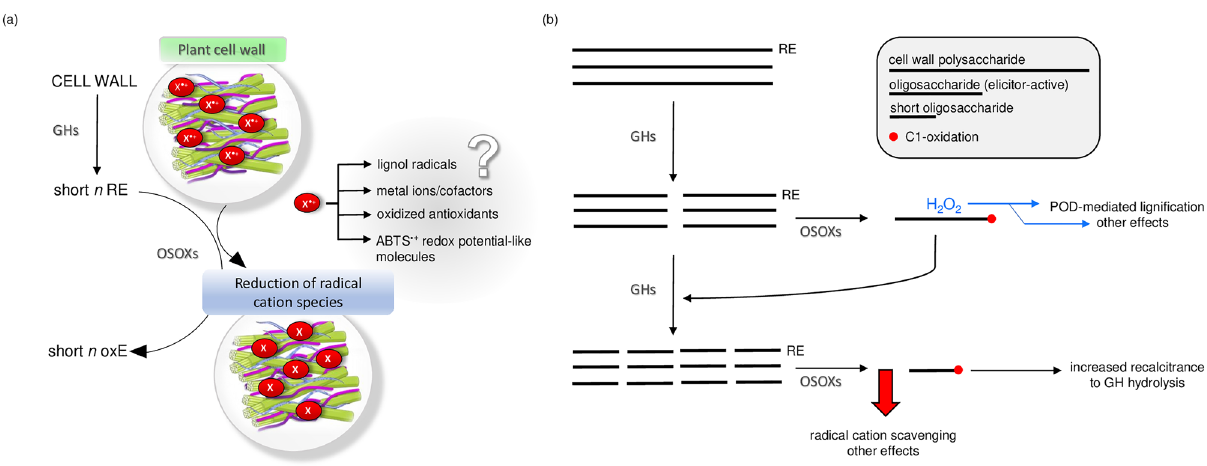
Figure 7. Proposed models of OSOXs as cell wall defense proteins. ( a ) Scavenging of unknown radical cations (X ·+ ) by the activity of OSOXs on short cell wall oligosaccharides. ( b ) Potential contribution of reaction products from OSOX activity in the maintenance of cell wall integrity during infection. [ GH glycoside hydrolase, OSOX berberine bridge enzyme-like oligosaccharide oxidase, oxE oxidized end, POD plant peroxidase, RE reducing